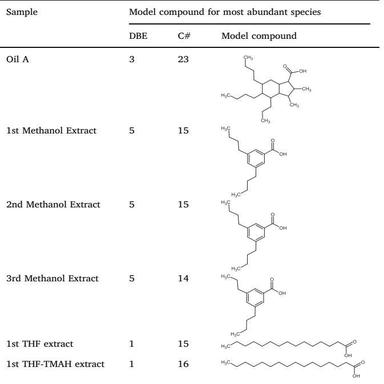
Possible layered distribution of acidic CxHyO3 species on reservoir rock.